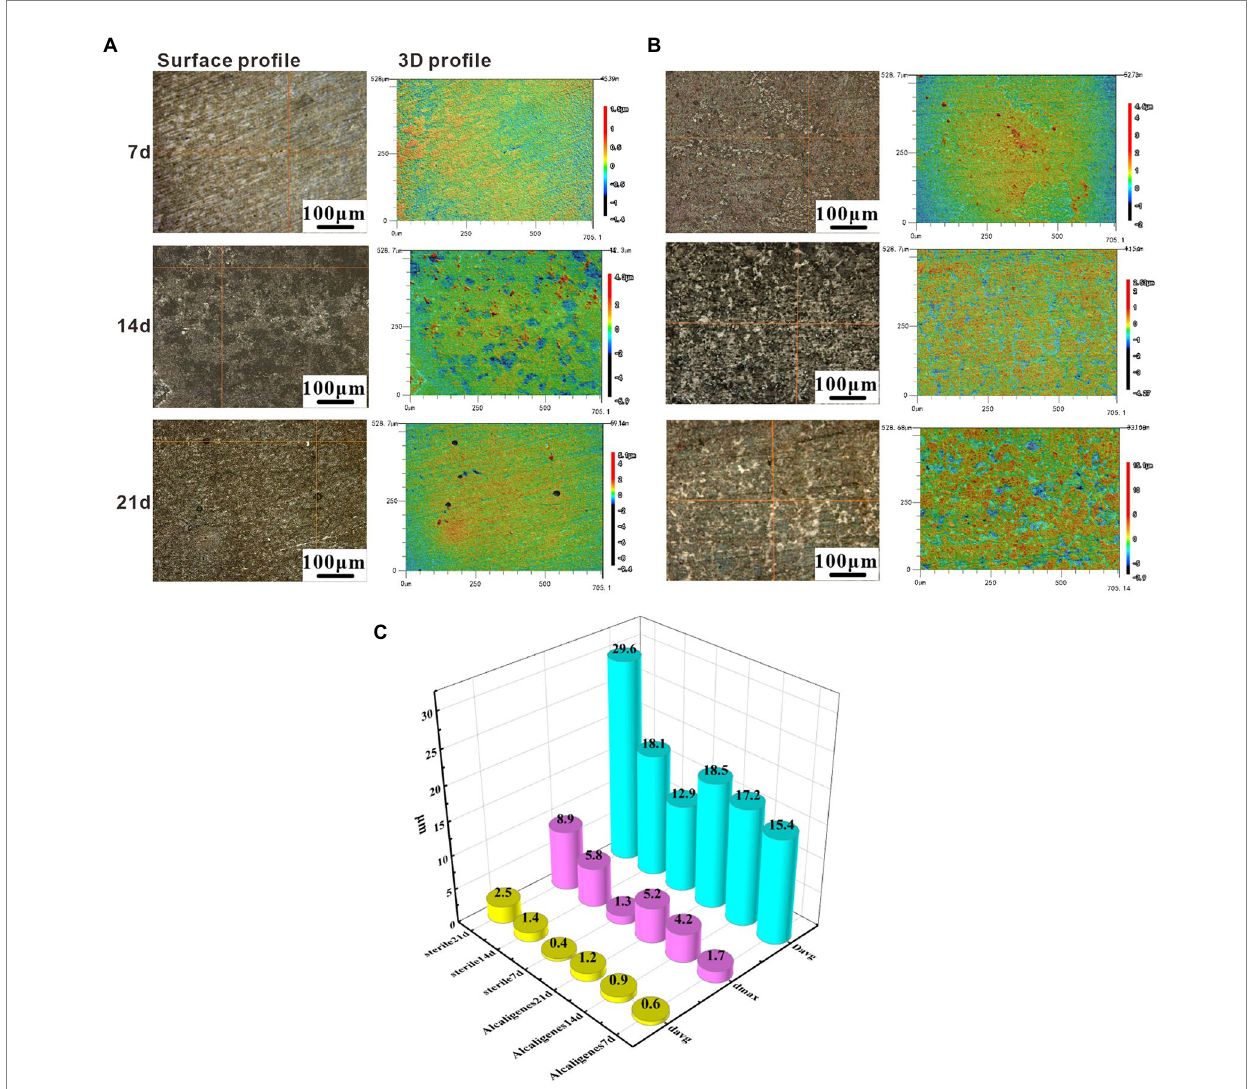
FIGURE 2 Removing surface corrosion products of X65 steel after immersion in (A) sterile and (B) Alcaligenes sp. media for different periods laser confocal scanning microscope (CLSM) image: surface topography and 3D profile. (C) Variation of average pitting parameters for X65 steel immersed in sterile and Alcaligenes sp. media for different